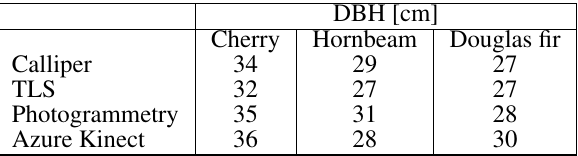
Table 1. Statical values of the deviation of Azure Kinect Point Cloud from Reference Point Cloud (Photogrammetry).